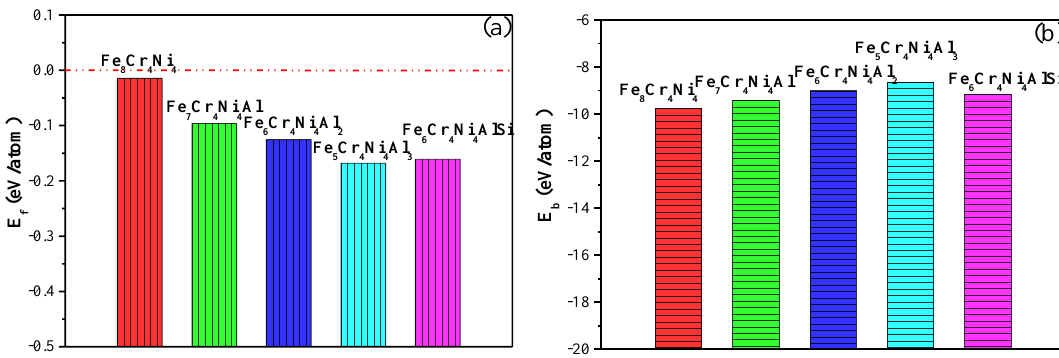
Figure 6. ( a ) Formation energy E f and ( b ) binding energy E b of Fe 8 Cr 4 Ni 4 , Fe 7 Cr 4 Ni 4 Al, Fe 6 Cr 4 Ni 4 Al 2 , Fe 5 Cr 4 Ni 4 Al 3 , and Fe 6 Cr 4 Ni 4 AlSi.